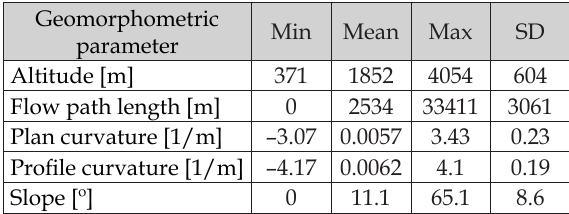
Table 1. Statistics of geomorphometric parameters.